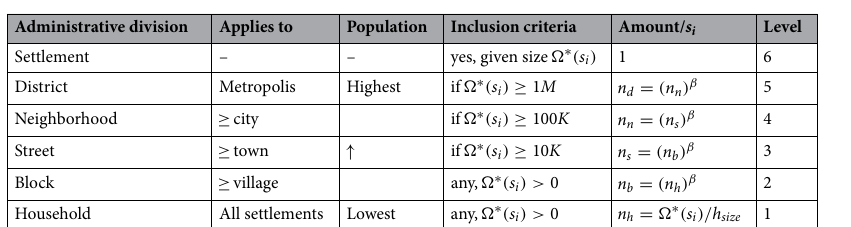
Table 1. Summary of the possible hierarchical administrative divisions characterizing a settlement s i , given its estimated real-world population � ∗ ( s i ) . Each division models a distinct hierarchical level in the settlement; based on its size, a settlement is modeled with 2–5 hierarchical levels